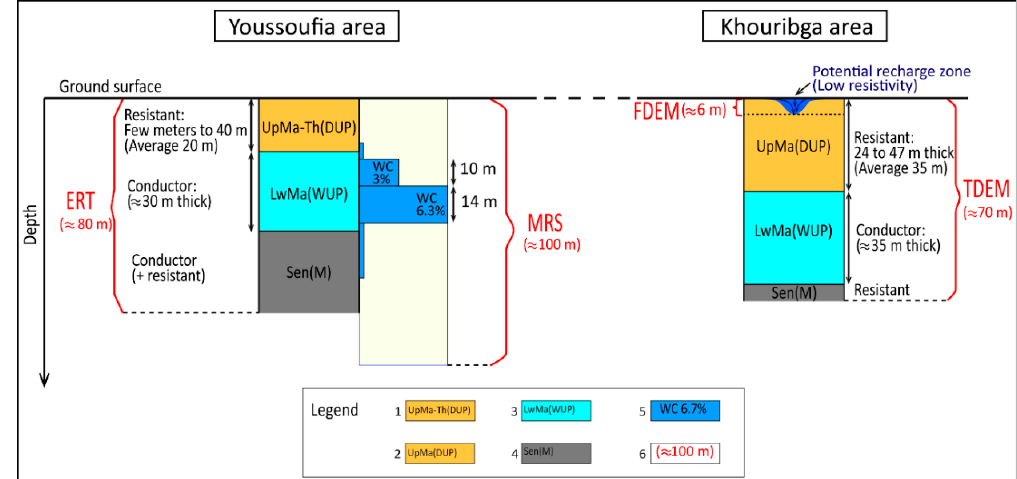
Figure 8. Summary illustration synthesizing the main outputs of the present study. 1: Upper